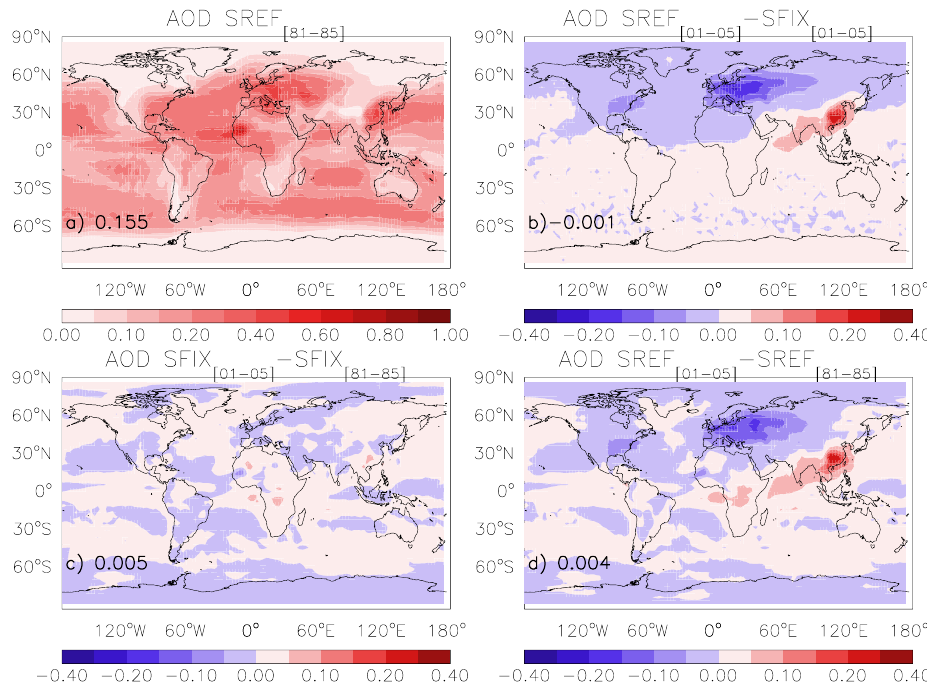
Fig. 14. Maps of total aerosol optical depth (AOD) and the changes due to anthropogenic emissions and natural variability. We show (a) the 5-yr averages (1981–1985) of global AOD; (b) the effect of anthropogenic emission changes in the period 2001–2005 on AOD, calculated as the difference between SREF and SFIX simulations; (c) the natural variability of AOD, which is due to natural emissions and meteorology in the simulated 25yr, calculated as the difference between the 5-yr average periods (2001–2005) and (1981–1985) in the SFIX simulation; (d) the combined effect of anthropogenic emissions and natural variability expressed as the difference between the 5-yr average